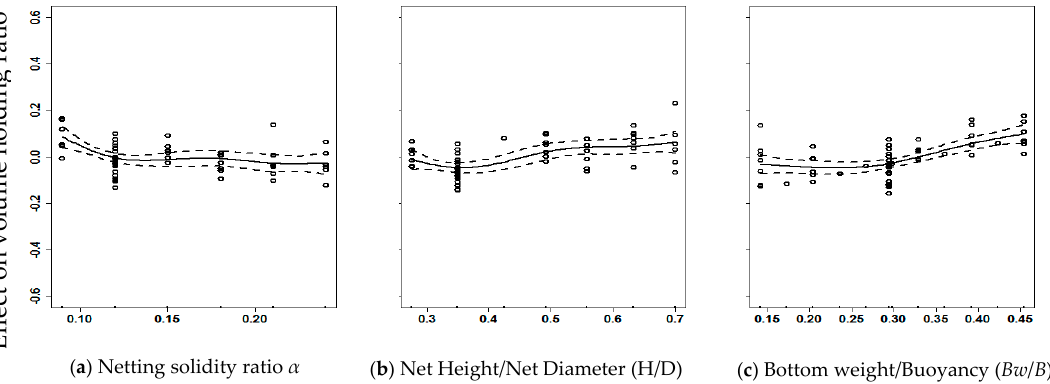
Figure 14. Relationships between design factors and volume holding ratio in the case of the GAM model. (The y-axis represents the partial effect of each variable; Dashed lines indicate 95% confidence bounds; Solid lines are smooth curves).